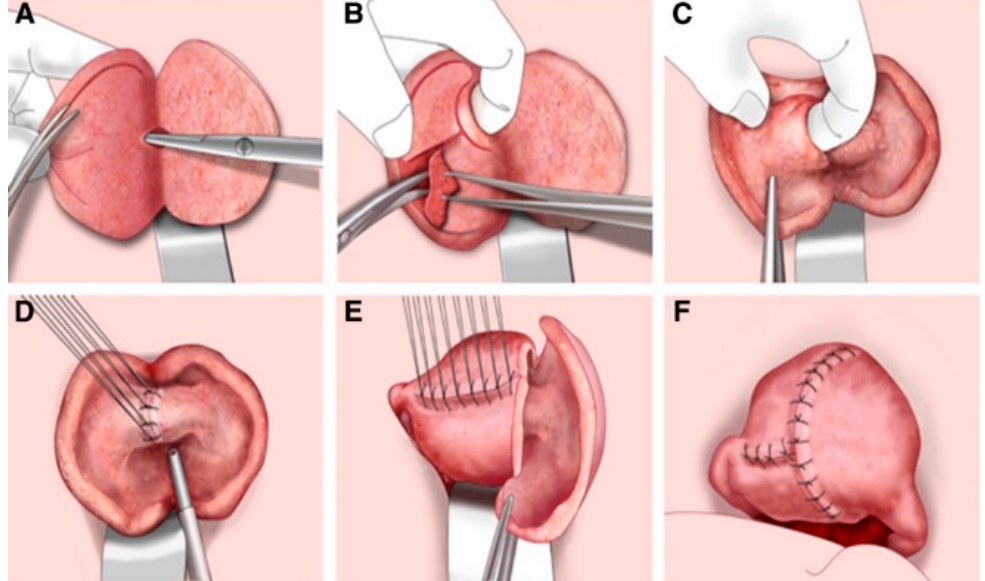
Figure 3. Schematic representation of the triple-flap method applied to the anterior and posterior uterine wall. The approach involves complete extraction of the uterine adenomyosis ( A – C ), followed by reconstruction of the uterine cavity ( D – F ). An endometrial uterine muscle flap is created by metroplasty and uterine muscle located on the serosal side is used to fill the large uterine wall muscle defect (E–F) (reprinted with permission from [95]).